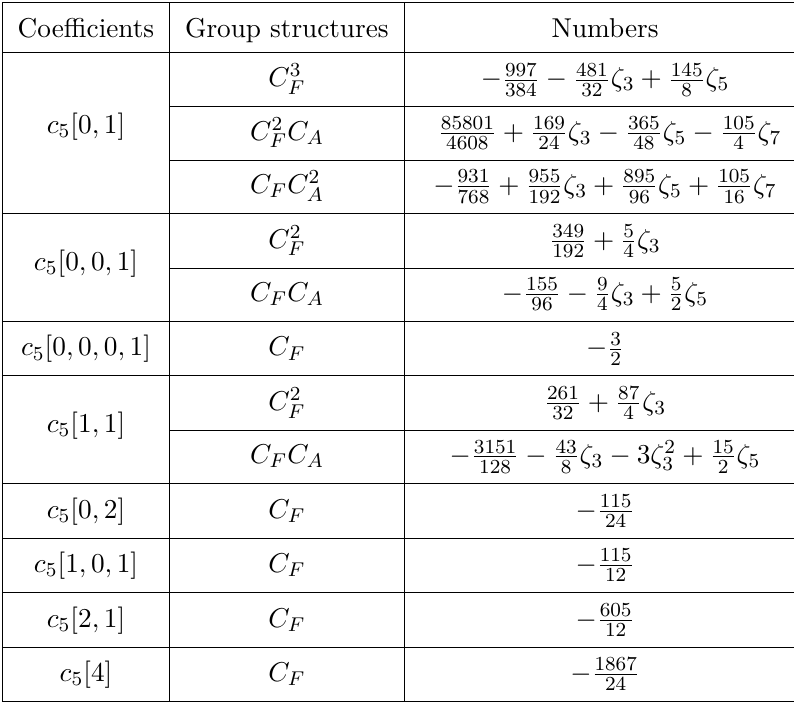
Table 6 . All extracted terms included in the { β } -expansion of coefficient c 5